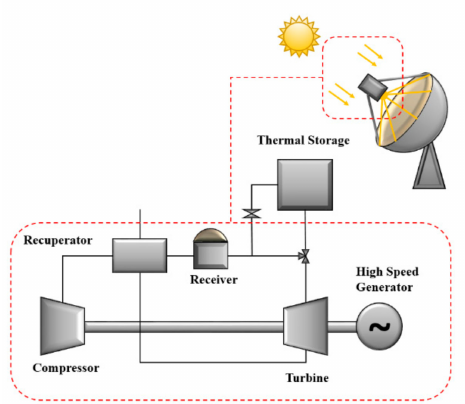
Figure 5. Concentrated solar power (CSP) dish and micro gas turbine (MGT) power plant